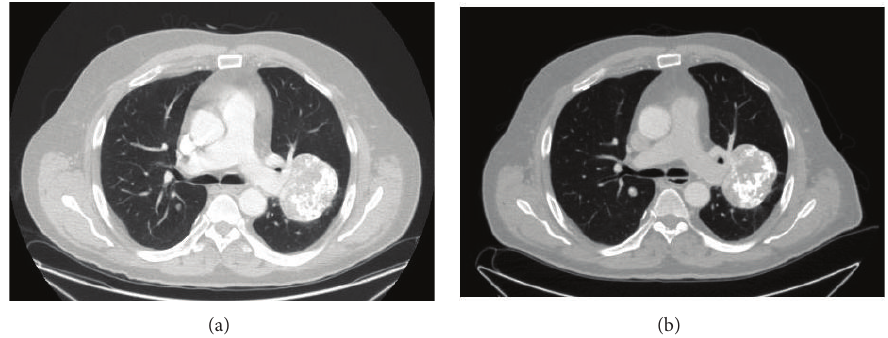
Figure 6: (a) Primary CT from the lung. (b) Control CT from the lung after two and half years of follow-up.